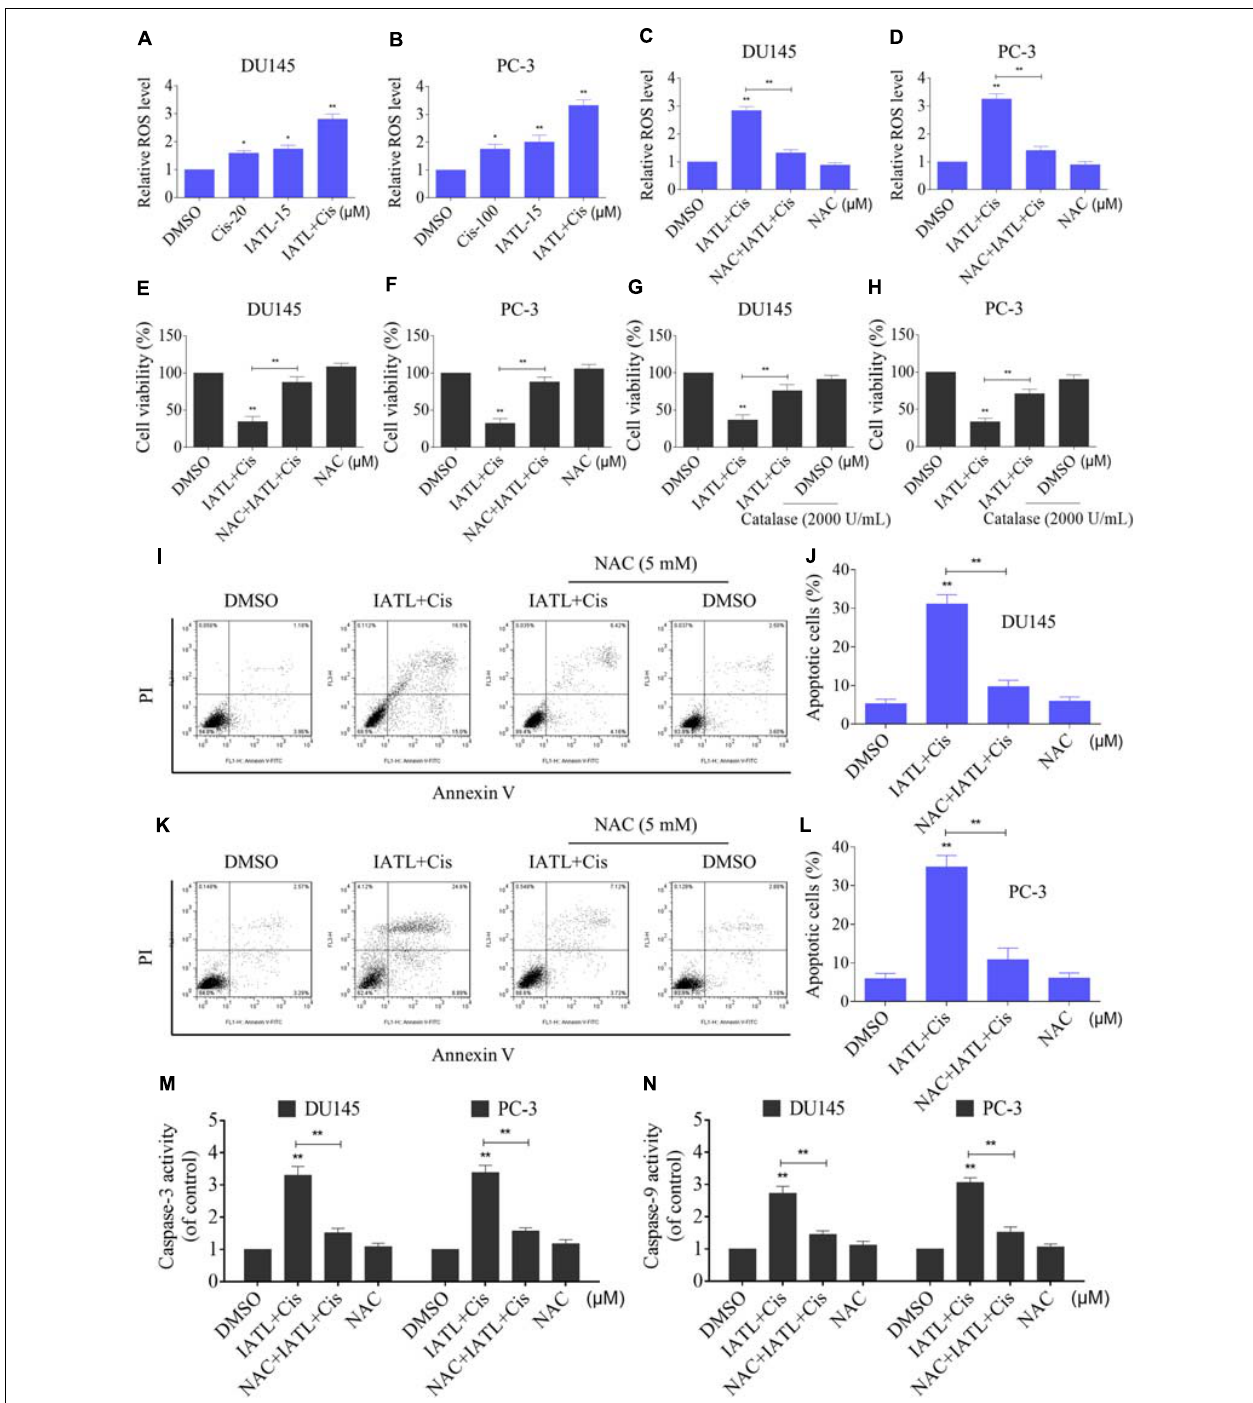
FIGURE 2 | IATL and cisplatin combination triggers ROS-dependent apoptosis in prostate cancer cells. (A,B) DU145 or PC-3 cells were treated with IATL or cisplatin alone or their combination at the indicated concentration for 2 h; cellular ROS levels were detected by using the DCFH-DA probe. (C,D) DU145 or PC-3 cells were preincubated with NAC (5 mM) for 2 h before exposure to the combination of IATL and cisplatin for 2 h; cellular ROS levels were detected by using the DCFH-DA probe. (E,F) DU145 or PC-3 cells were preincubated with NAC (5 mM) for 2 h; cell viability was detected by an MTT assay after being treated with the combination of IATL and cisplatin for 24 h. (G,H) DU145 or PC-3 cells were preincubated with catalase (2,000 U/mL) for 2 h; cell viability was detected by an MTT assay after being treated with the combination of IATL and cisplatin for 24 h. (I–L) DU145 or PC-3 cells were preincubated with NAC (5 mM) for 2 h; the cell apoptosis rate was detected by flow cytometry after being treated with the combination of IATL and cisplatin for 24 h. (M,N) DU145 or PC-3 cells were preincubated with NAC (5 mM) for 2 h; caspase-3 and caspase-9 activity was measured by an assay kit after being treated with the combination of IATL and cisplatin for 20 h. * p < 0.05, ** p < 0.01.